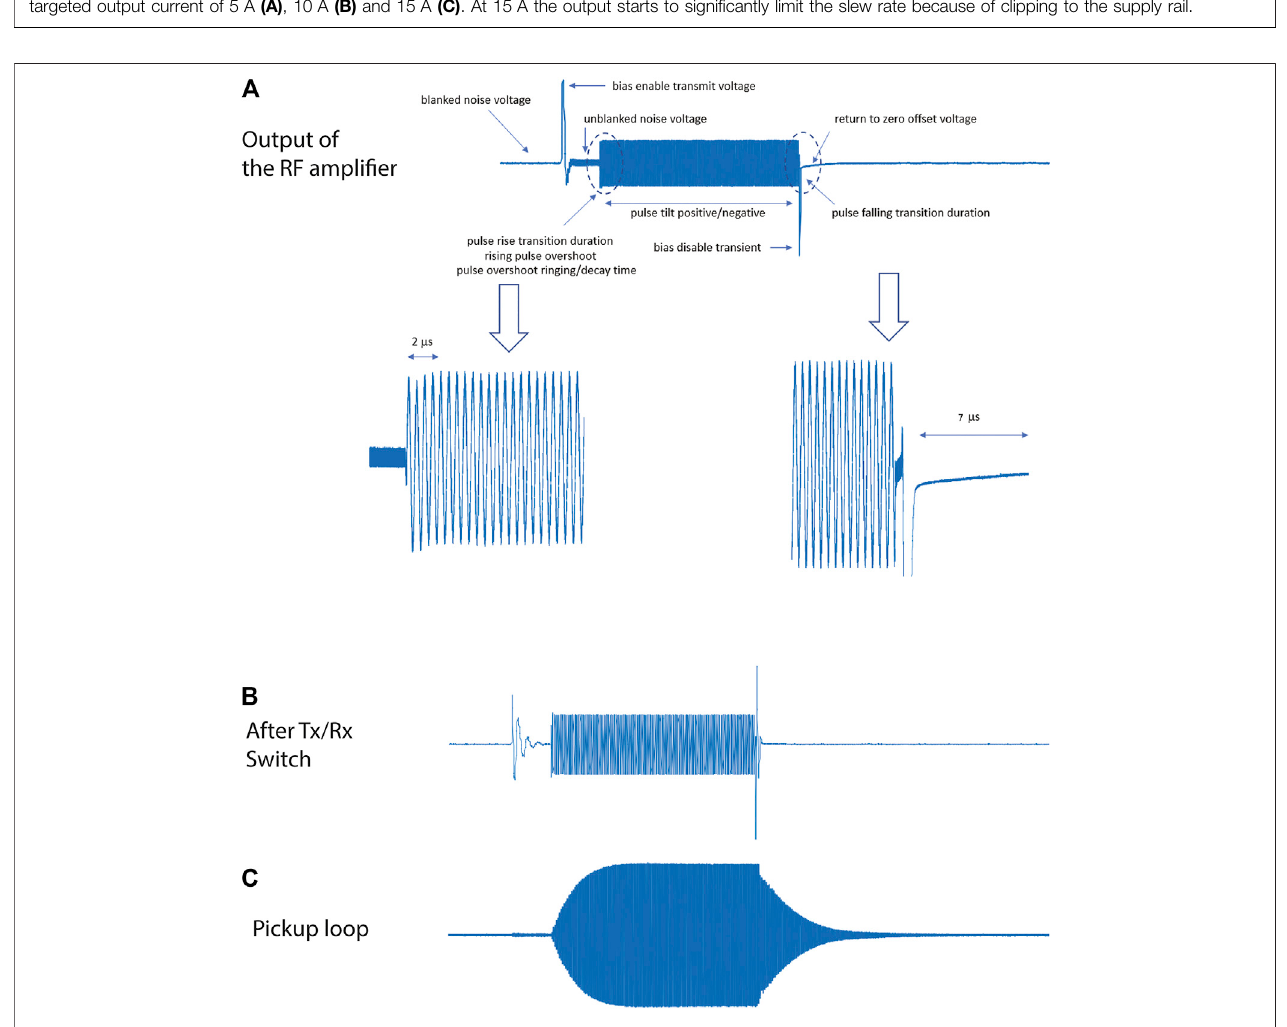
FIGURE 9 | Digital traces of a 100 µs pulse at different stages of the transmit chain. The expanded views (A) show different features of the ampli fi ed pulse shape. The2.15 MHzsquarepulseis100 μ slong,precededbya5 VTTLun-blankingtriggersignal20 μ spriortotheRFpulse.ThesamesignalisshownaftertheTx/Rxswitch (B) and received by a un-tuned pickup loop (C)